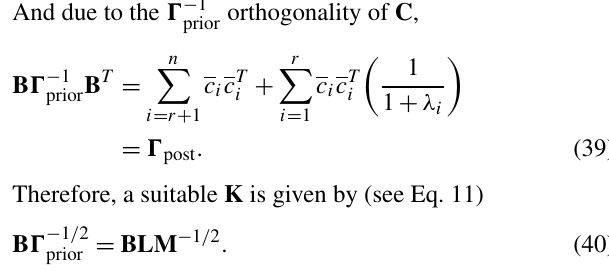
trajectory. Solid lines: Hessian-based T from sampling the posterior density. In T